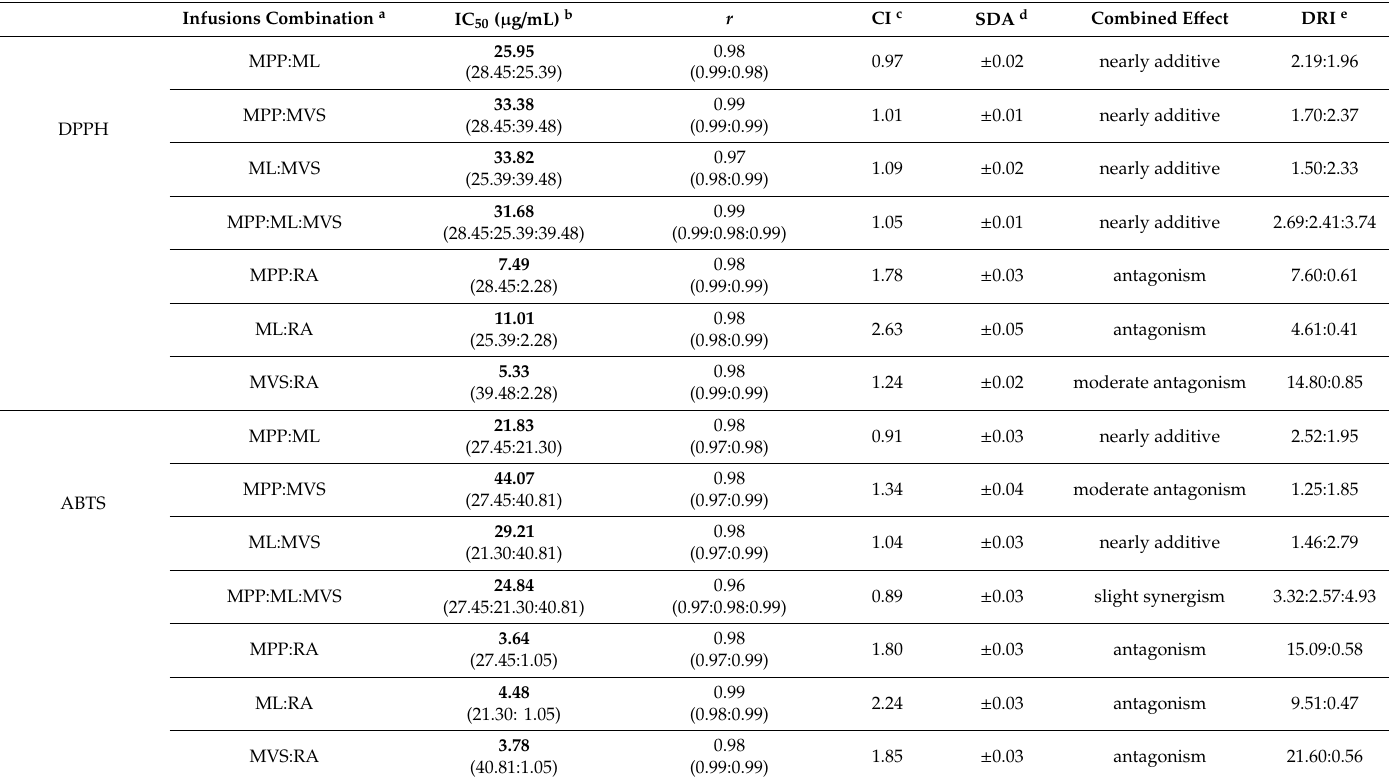
Table 3. Interaction analysis of mutual mint infusions and mint infusions / rosmarinic acid combinations in DPPH and ABTS assays: IC 50 , CI, and DRI values of equal mass concentration infusions combinations at 50% inhibition dose